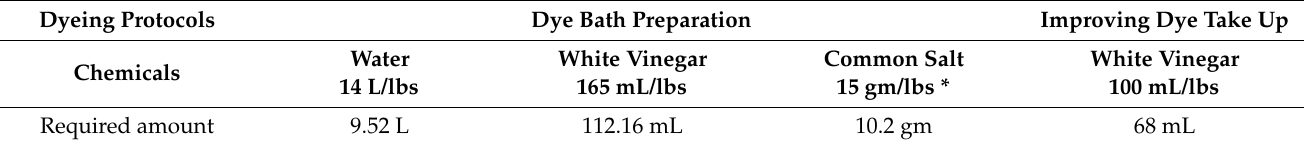
Table 4. Amount of chemicals required for the dye bath for dyeing one batch of carpets. Correspond- ing batch weight ≈ 308.6 gm.